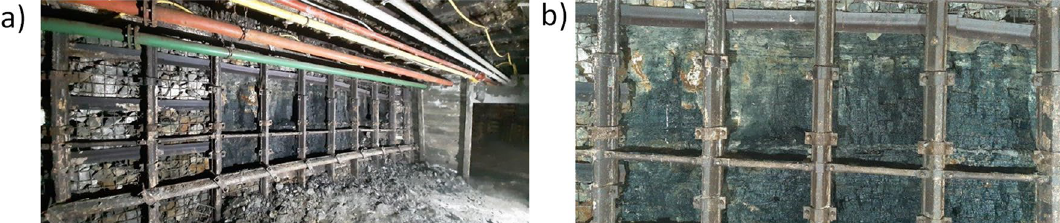
Figure 2. ( a ) Uncovered sidewall and ( b ) exposed hard coal bed on the sidewall of the test